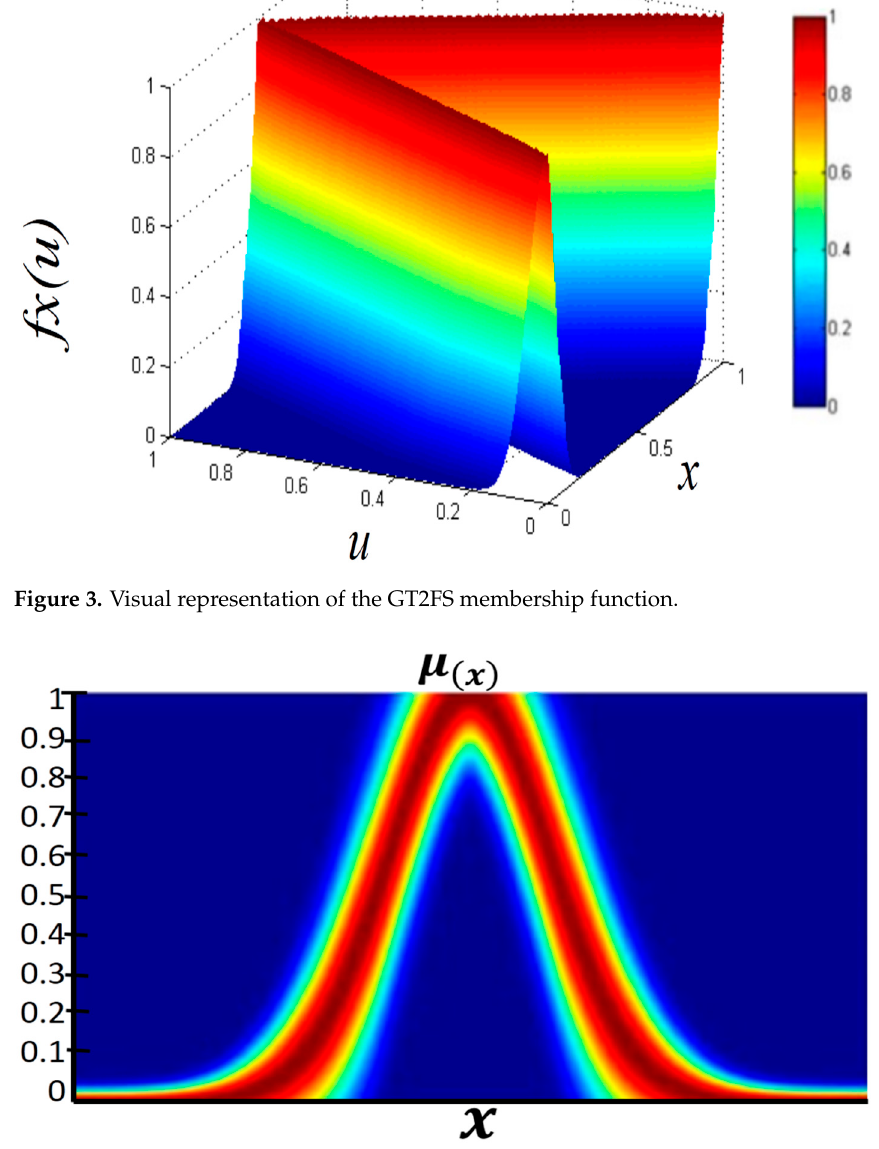
Figure 4. Visual representation of the FOU of the GT2FS membership function. The α -plane for a general type-2 fuzzy set, in this case (cid:101) A , is denoted by Ã α , and it is the union of all primary membership functions of Ã, which secondary membership de- grees are higher or equal to α (0 ≤ α ≤ 1) [48,49]. The visual representation of an alpha plane can be found in Figure 5, in the same way the expression of the alpha plane is given by Equation (9).